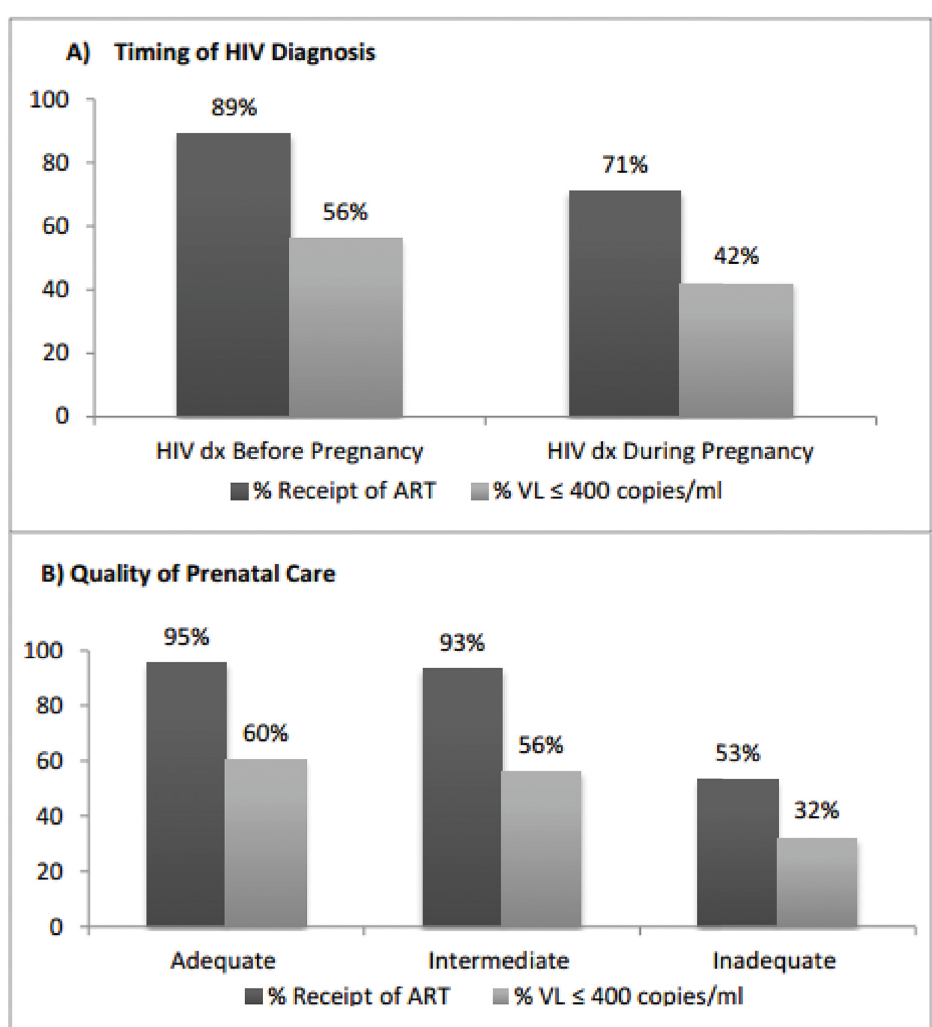
Fig 1. Receipt of ART and Viral Suppression by A) Timing of HIV Diagnosis and B) Quality of Prenatal Care. Adequacy of prenatal care was measured using the Kessner Index, a validated index of quality of prenatal care which takes into account timing of entry in prenatal care, the number of prenatal visits and gestational age at infant delivery; ART: antiretroviral; VL: viral load; dx: